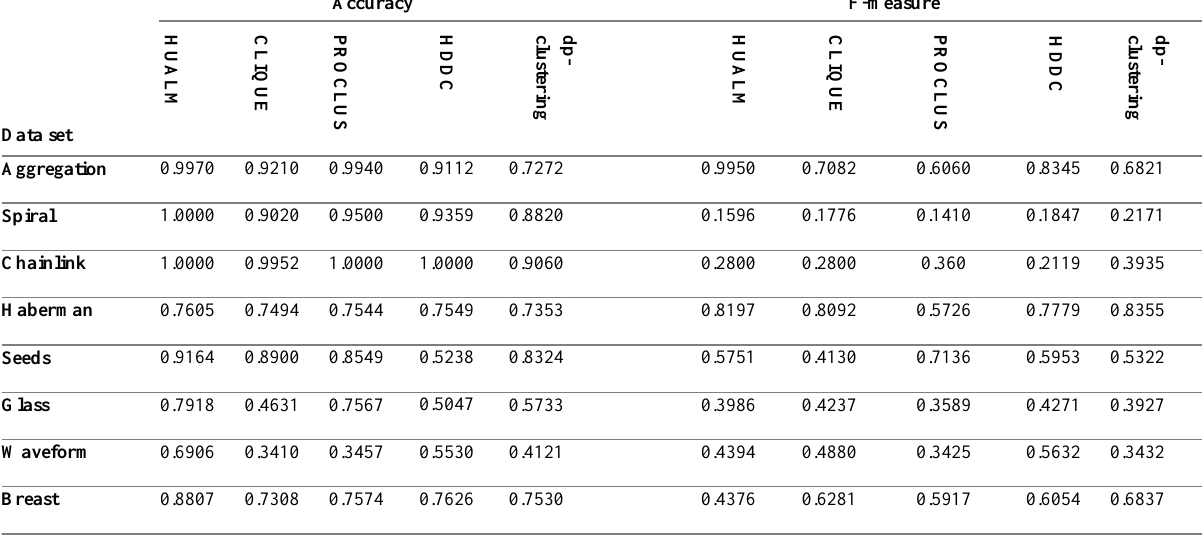
Table 2. Validity indexes for clustering methods.